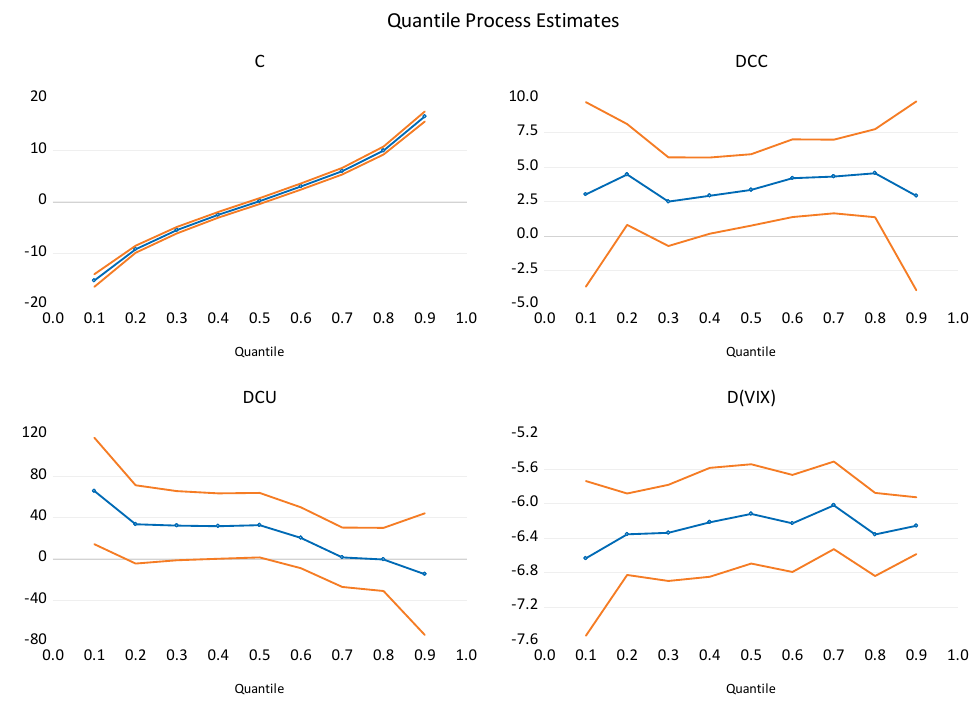
Figure 8. Quantile Process Coefficients. Intercept is C and the remaining graphs show the coefficients of the stationary variables consumer confidence, capacity utilization, and VIX over nine quantiles.